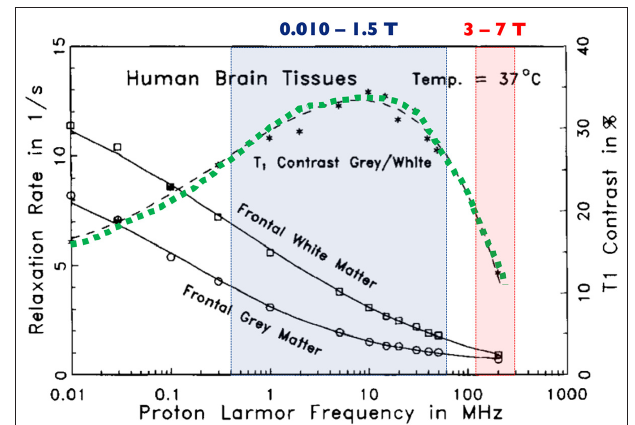
FIGURE 5 | Relative T 1 contrast in human brain samples as a function of Larmor frequency. The green dotted line shows that the relative contrast between gray and white matter is higher when operating between 10 mT and 1.5T (shaded blue box) and decreases dramatically at very high to ultra-high field strengths (shaded red box). Modified, with permission, from Fischer et al. [